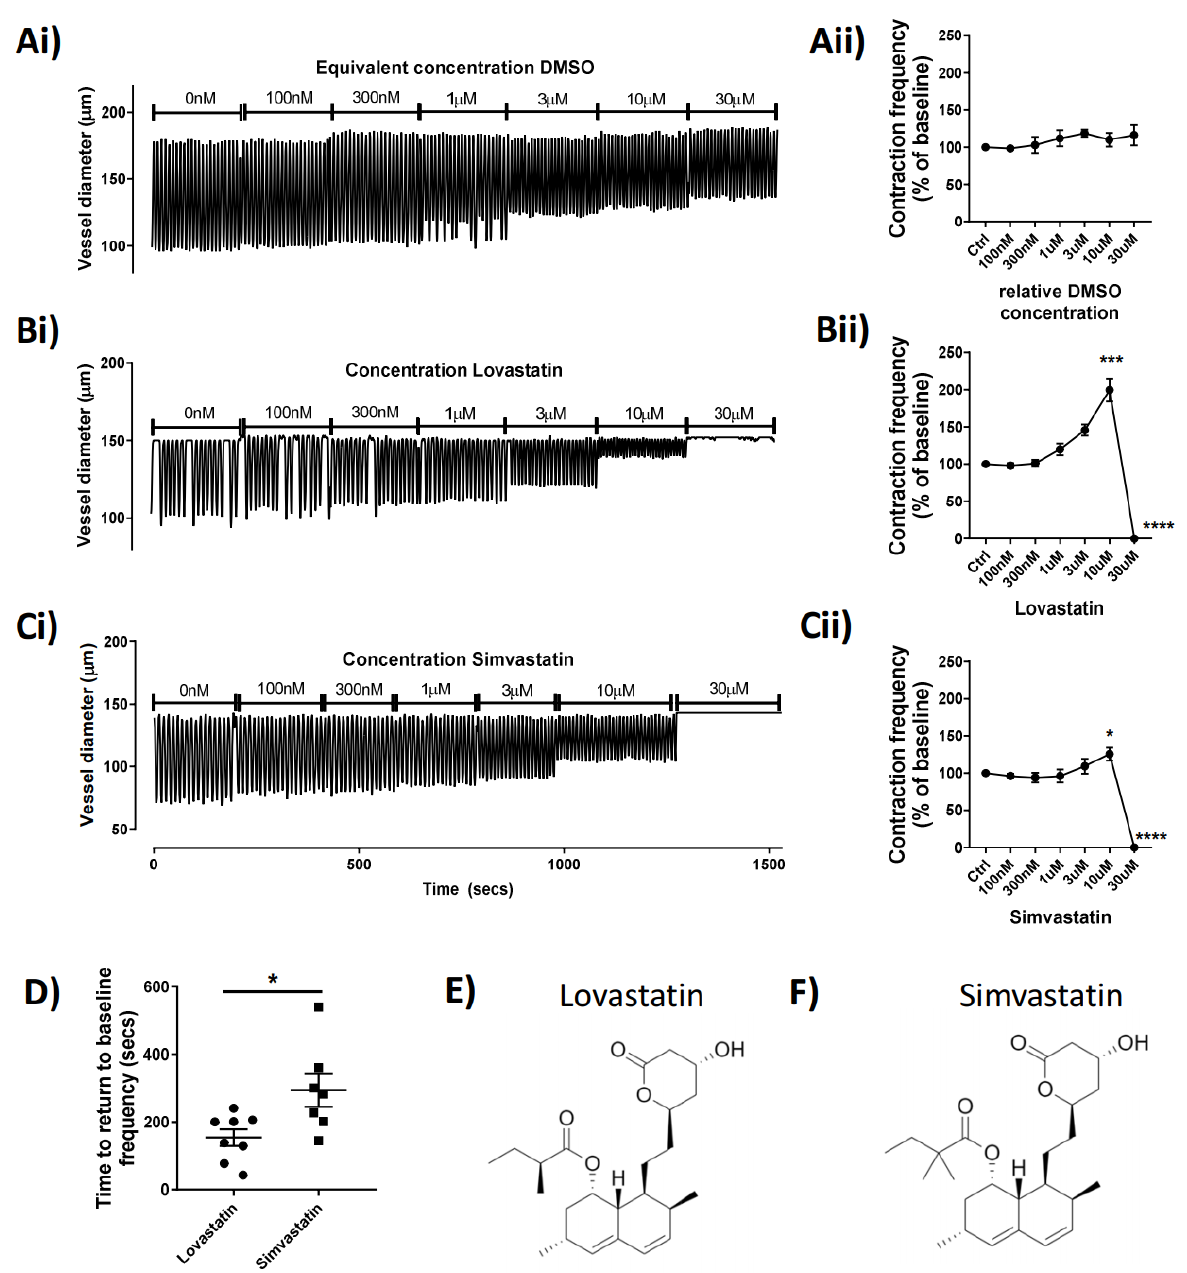
Figure 1. Concentration-dependent effect of statins on the contractibility of rat mesenteric collecting lymphatic vessels in situ. Isolated and pressurized rat mesenteric lymphatic vessels were incubated with increasing concentrations of the statins or a relative concentration of DMSO ( Ai – Ci ) Representative traces monitored for a 3 min period at each concentration. ( Aii – Cii ) Contraction frequency of vessel expressed as baseline-corrected percentage for each vessel tested. ( D ) Analyzed time for flatlined vessel to return to baseline contraction after statin treatment. Skeletal structures of ( E ) Lovastatin and ( F ) Simvastatin drawn using ChemDraw. Vessel contraction frequency is represented as mean ± SEM of n = 5–12 individual experiments. * p < 0.05, *** p < 0.001, **** p < 0.0001 vs. baseline. One-way ANOVA with Dunnet’s multiple comparisons